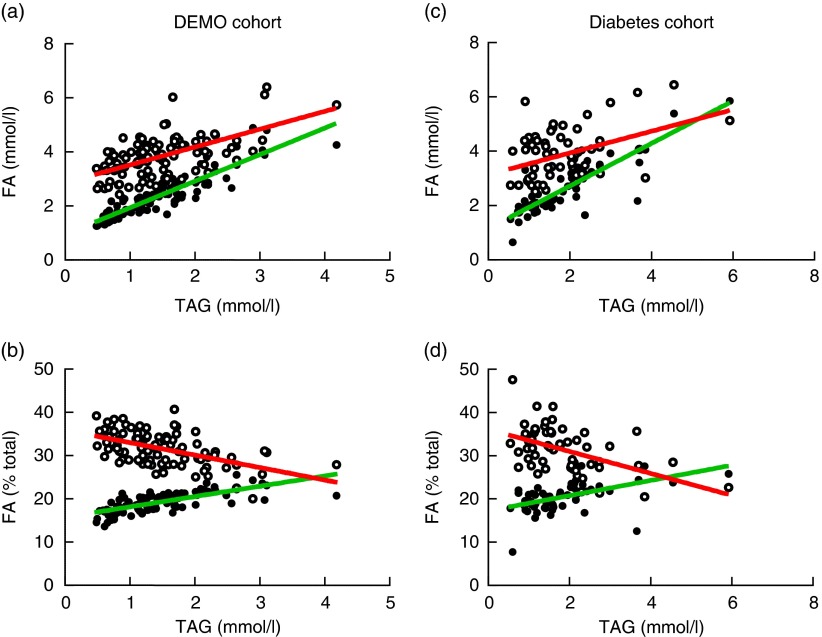
Impact of fatty acid (FA) expression method on the TAG relationship with oleic acid (OA, C18 : 1n-9) and linoleic acid (LA, C18 : 2n-6). The relationship between TAG and the most abundant circulating FA, LA (31 %), differs (, C18 : 2n-6) on the basis of the method of FA expression: concentration (mmol/l) (a); or as percentage of total (b) in the Diet, Exercise, Metabolism and Obesity in Older Women (DEMO) cohort. The same relationships were also examined in the replicate population (the diabetes/metabolic syndrome cohort; right panels) as concentration (mmol/l) (c); or as percentage of total (d). The relationship between TAG and OA (19–20 %) is unaffected (, C18 : 1n-9) by the method of FA expression. For visualisation, the linear regression line is shown for each data set.